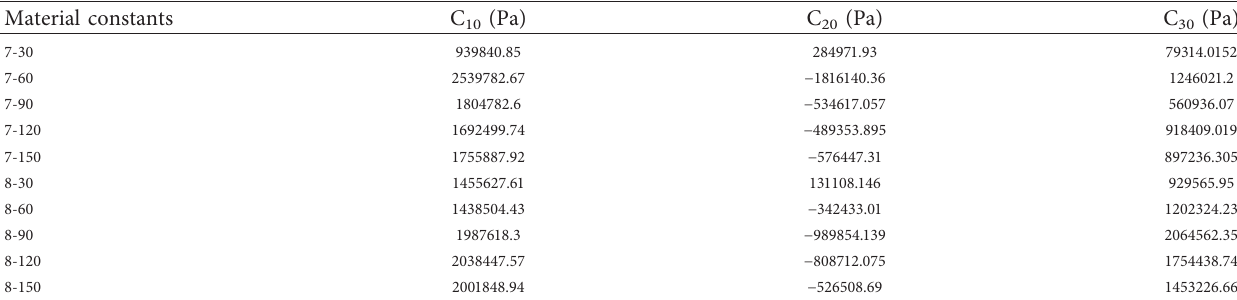
Table 2: Material constants of the Yeoh model for two rubber materials at five temperatures. Material